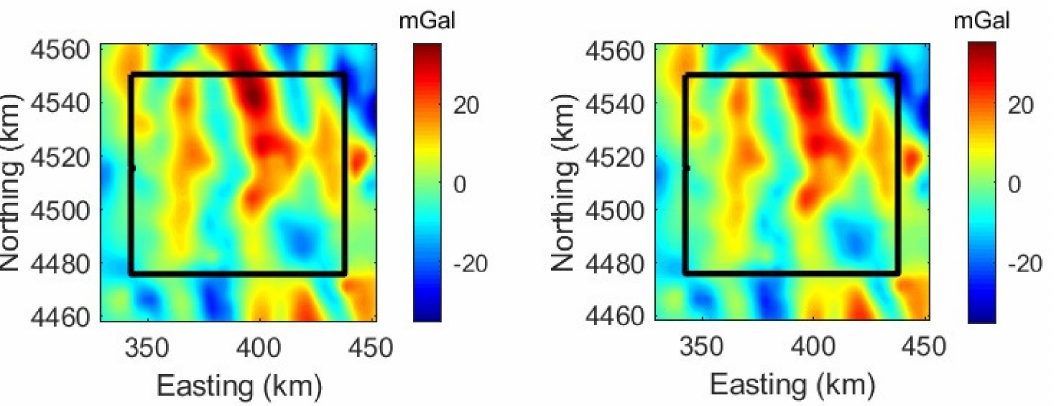
Figure 8. Comparison of the observed (left panel) and predicted (right panel) gravity data produced by 3D inversion with a priori density contrast model.